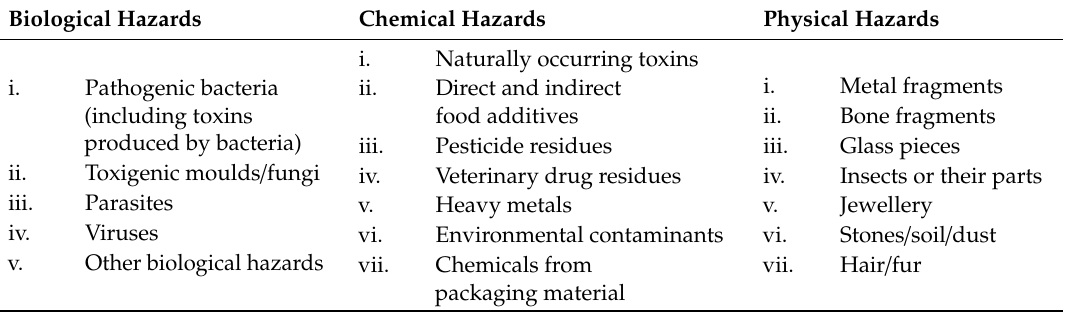
Table 1. Main categories of food safety hazards associated with milk and dairy products (adopted from the Food and Agricultural Organization (FAO),